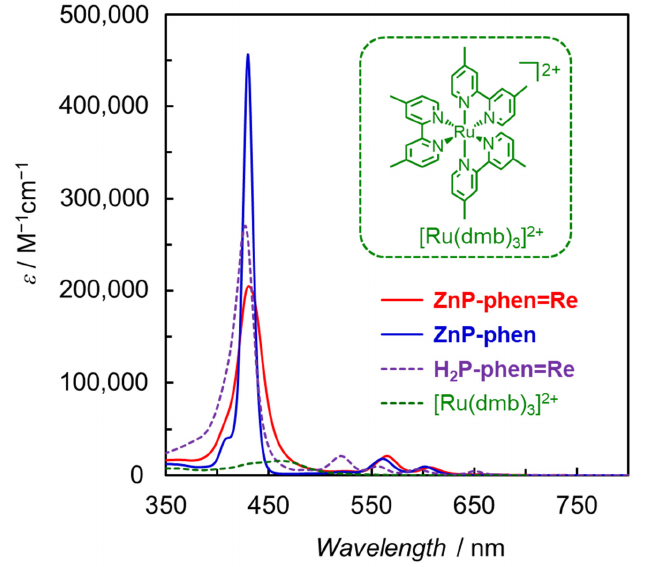
Figure 7. UV–vis absorption spectra of ZnP-phen=Re, ZnP-phen, and H 2 P-phen=Re with [Ru(dmb) 3 ] 2+ [43,44]. The strong electronic interactions observed in the UV–vis absorption spectra also af- fected the emission spectra. The fluorescence of the free-base and Zn porphyrins was al- most completely quenched by the introduction of the Re complex. Considering that the fluorescence quenching occurs even in H 2 P-phen=Re , in which the intramolecular elec- tron transfer from the S 1 of porphyrin to the Re complex is thermodynamically very unfa- vorable, the quenching was induced by a rapid intersystem crossing caused by the heavy Re atom. Surprisingly, the emission spectrum of ZnP-phen=Re measured in carefully de- gassed N,N -dimethylacetamide (DMA) under Ar showed weak but distinct room temper- ature phosphorescence of Zn porphyrin at ca 800 nm (Figure 8) [43]. Herein, DMA is a solvent practically used for the photocatalytic CO 2 reduction [45]. Phosphorescence of Zn porphyrin is generally not observed at room temperature, but the heavy atom effect of Re would induce a unique room temperature phosphorescence. In contrast, H 2 P-phen=Re did not show room temperature phosphorescence under the same conditions, probably because free-base porphyrin has a much lower phosphorescent ability than Zn porphyrin [44,46]. The phosphorescence of the Zn porphyrin was efficiently quenched by the elec- tron donor, BIH, whereas the fluorescence at 610 and 660 nm was hardly quenched. This reflects that the intermolecular electron transfer with BIH more efficiently proceeds with the long-lived T 1 than the short-lived S 1 of porphyrin. The efficient phosphorescence quenching indicates that the quantitative photoinduced electron transfer occurs from BIH to the T 1 of ZnP-phen=Re .